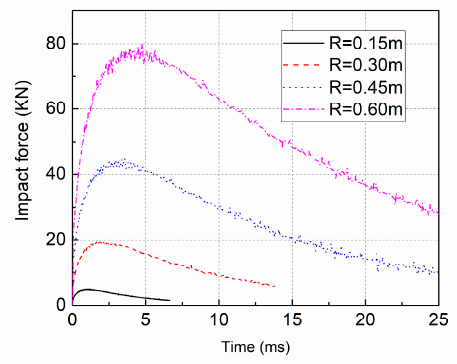
Figure 12. The time history of the impact force with different radii.